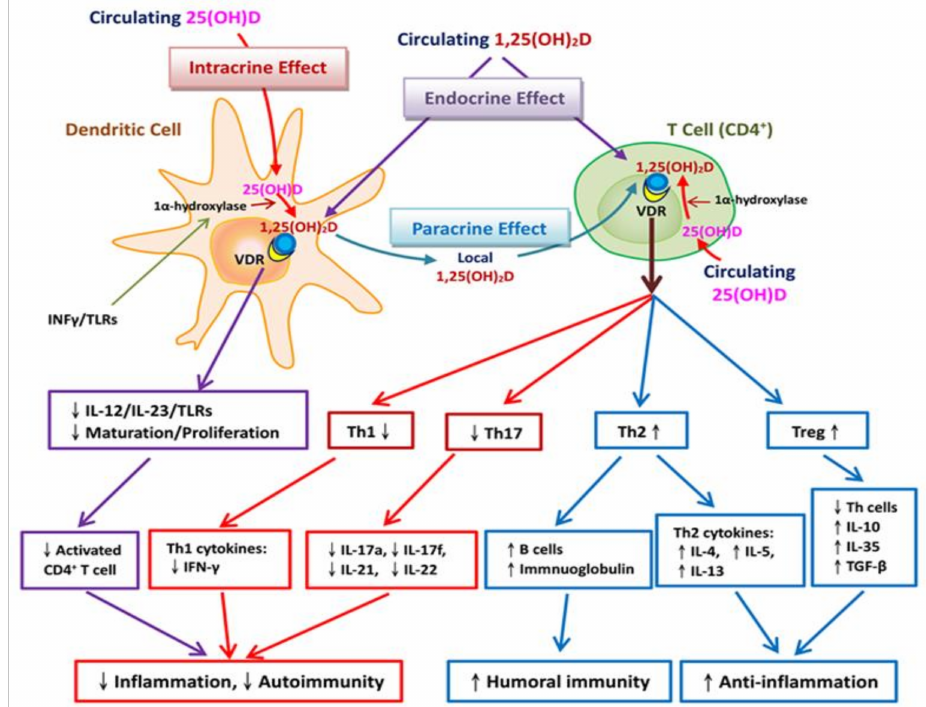
Figure 3. Vitamin D-related adaptive immune responses to COVID-19. Dendritic cells expressing 1 α -hydroxylase and the vitamin D receptor (VDR) can utilize circulating 25-hydroxyvitamin D [25(OH)D] for intracrine responses through localized conversion to active vitamin D [1,25(OH)2D]. Intracrine synthesis of 1,25(OH)2D inhibits the maturation of dendritic cells, thereby modulating CD4 + T cell function. CD4 + T cell responses to 25(OH)D may also be mediated in a paracrine manner, with 1,25(OH)2D acting on VDR-expressing CD4 + T cells. VDR-expressing CD4 + T cells are also potential targets for systemic 1,25(OH)2D (endocrine effect). Vitamin D acts on dendritic cells to stimulate effector CD4 + cells to differentiate into one of the four types of CD4 + cells. Activated T cells also express VDR. Under normal circumstances, vitamin D increases T helper (Th) 2 (Th2) cytokines (e.g., IL-10) and the efficiency of regulatory T (Treg) lymphocytes. Vitamin D inhibits the development of Th1 cells, which are associated with the cellular immune response. In addition, vitamin D promotes the association of Th2 cells with humorally mediated immunity. Thus, vitamin D promotes the shift from Th1 to Th2 cells. Vitamin D also inhibits the development of Th17 cells, which play roles in tissue damage and inflammation. The fourth group of CD4 + T cells, Tregs, suppress the function of vitamin D. Circulating and local active vitamin D acts through intracrine, paracrine, and endocrine effects to regulate adaptive immunity in SARS-CoV infection. First, it suppresses the maturation of dendritic cells and weakens the antigenic presentation. Second, it increases cytokine production by CD4 + T cells and promotes the efficiency of Treg lymphocytes. Finally, it suppresses Th1 and Th17 cytokine secretion, as well as related tissue destruction